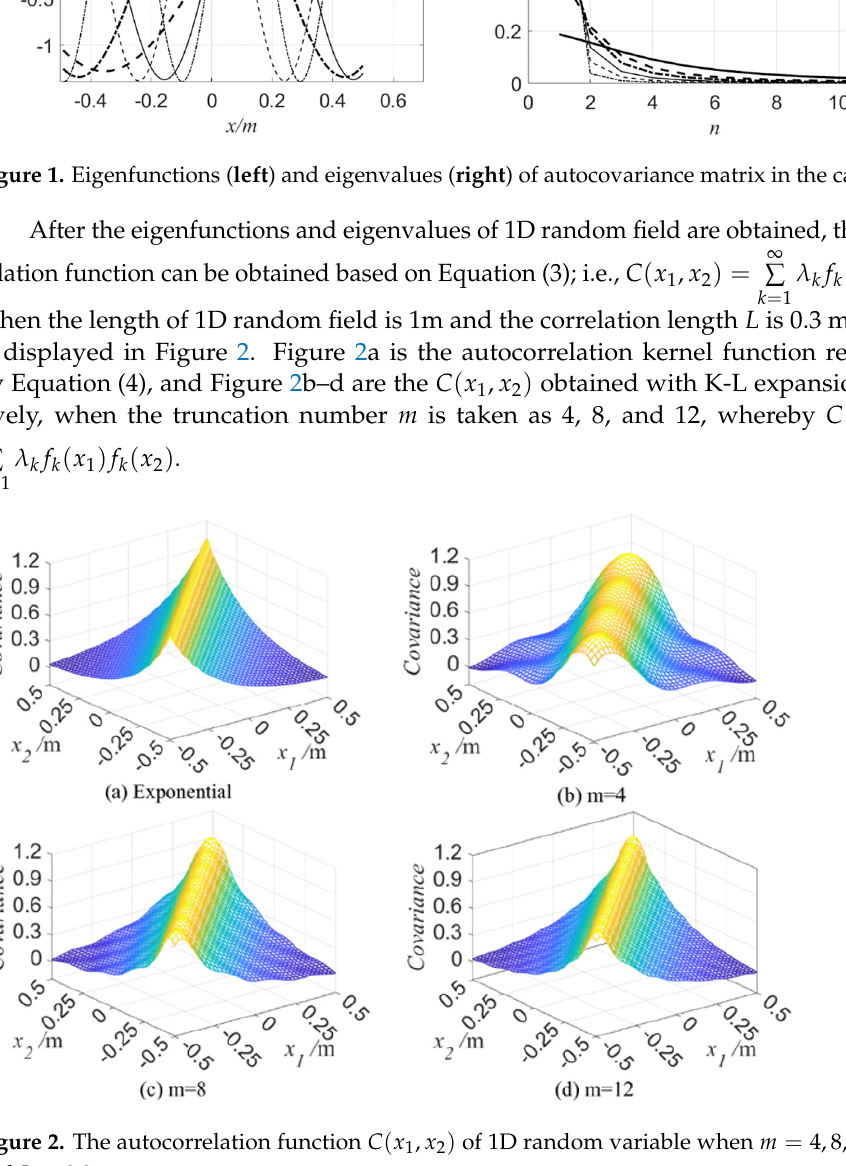
Figure 2. The autocorrelation function C ( x 1 , x 2 ) of 1D random variable when m = 4,8,12, l = 1 m , and L = 0.3 m .